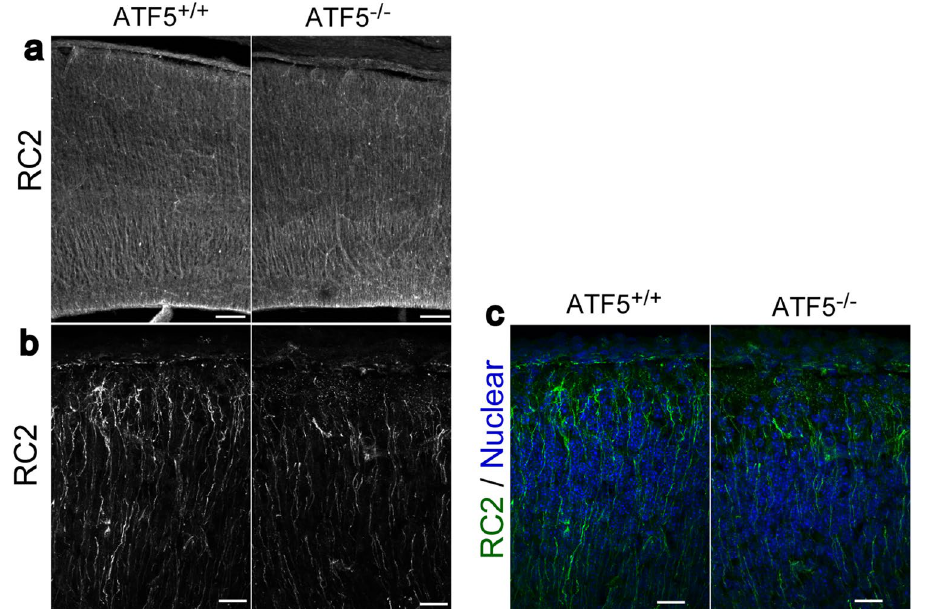
Figure 6. Radial glial process reaching the surface of the cerebral cortex were reduced in the ATF5-deficient mice. ( a – c ) Immunostaining of cortical sections with an RC2 antibody on embryonic day 18 (E18). Higher magnification images are shown in ( b ) and ( c ). Scale bars represent 100 µm in ( a ), 20 µm in ( b ) and ( c